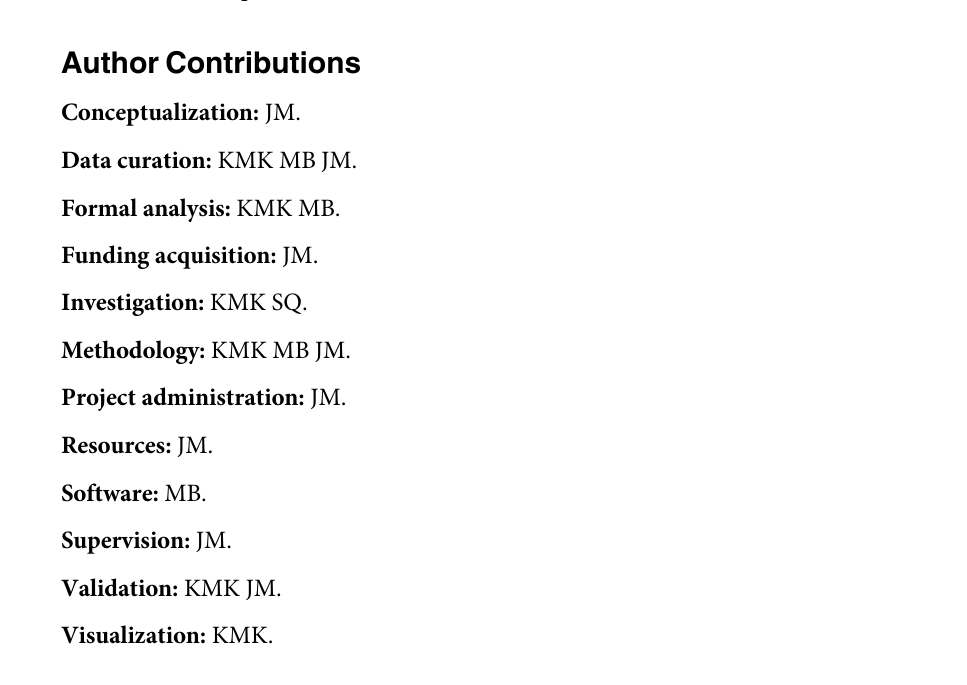
S3 Fig. Compaction of aggregated arrays. In the main analysis we introduced an upper limit for the volume of the arrays, in order to restrict the analysis to individual arrays. Here, we are presenting the analysis of the arrays whose volumes exceeded this limit. Thus, we are present- ing data were two or more arrays are interacting and consequently inter-array interaction energies are also included. The histograms of observed compaction values are again fitted using Gaussian functions and the mean of theses Gaussians together with the standard error are displayed in comparison to the result of the single arrays. Remarkably the observed decrease in compaction between 50 mM and 75 mM salt is vanishing when aggregates are ana- lysed. (a) Plot of salt dependent compaction for single (red) and multiple (blue) arrays. (b) Summary of analysed AFM data for array